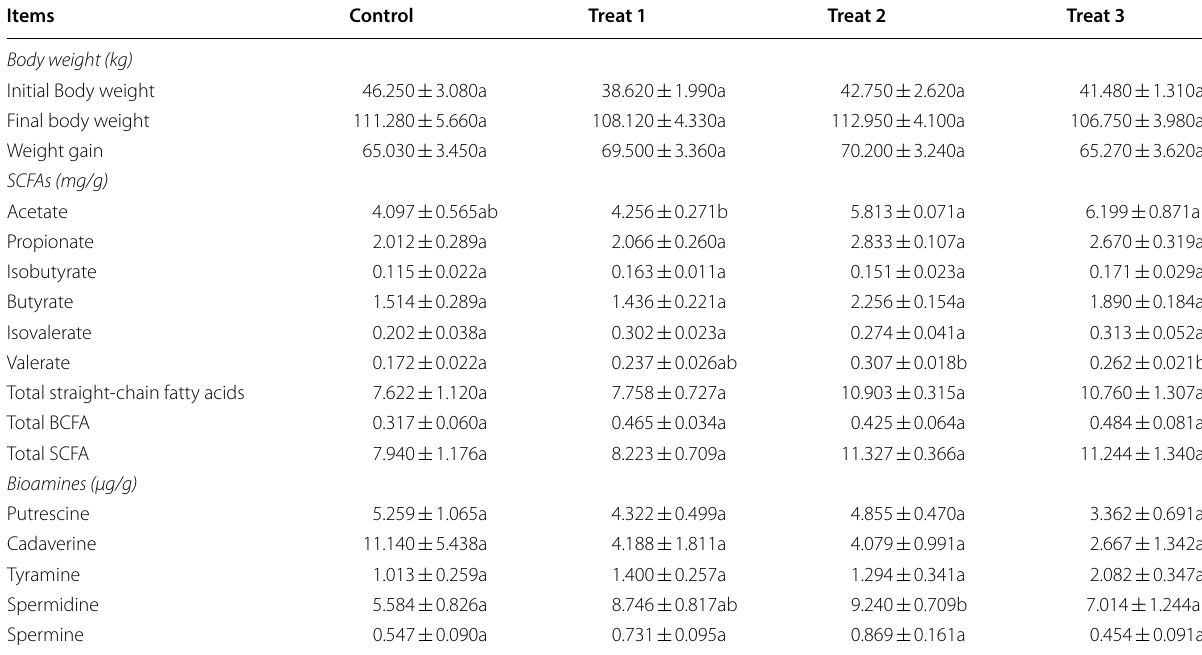
Data was expressed as mean SE obtained from 6 individual pigs each. One-way ANOVA with Tukey’s post hoc test or Mann–Whitney U-tests was used to evaluate ± the difference of fecal metabolites in different groups. Significant difference is indicated by different letters. The group control, treat 1, treat 2, and treat 3 signify that feed is supplemented with 0, 5%, 10%, or 15% FML,